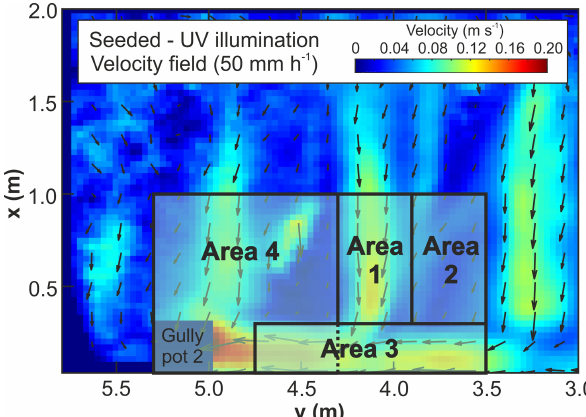
Figure 4. Areas of the model surface analyzed with the image ve- locimetry methods considering different types of flows that are de- veloped in urban catchments: perpendicular drainage to the curb (Areas 1 and 2), curb flow (Area 3), and vicinities of gully pot 2 (Area 4). The velocity field plotted to understand the choice of the analyzed areas was taken from Naves et al. (2019a), in which the LSPIV was satisfactorily